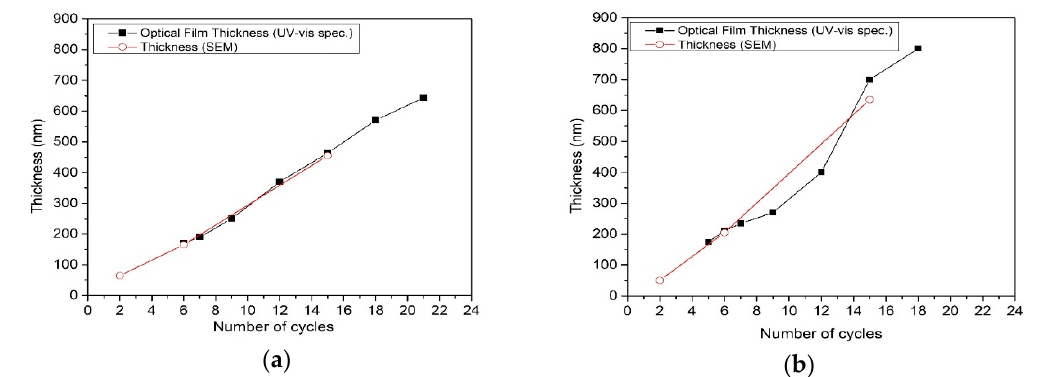
Figure 5. TiO 2 thin film thickness dependence on number of spray cycles and solution concentration ( a ) 0.1M and ( b ) 0.2M. Film thickness values obtained from SEM cross-sectional images and UV-Vis spectroscopy using Fizeau method.